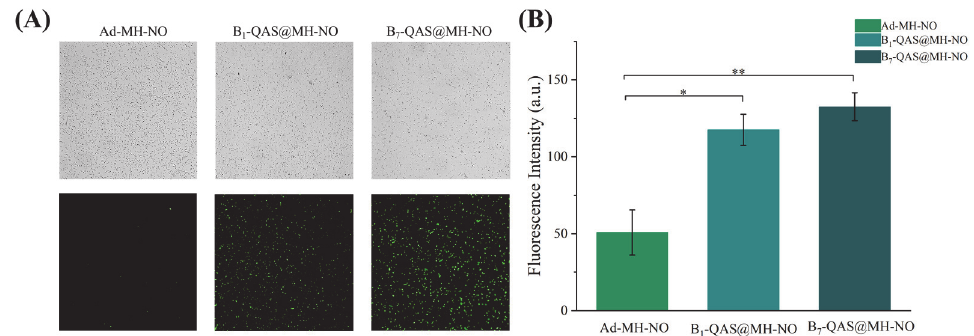
Figure 7. ( A ) NO fluorescence imaging in bright and dark fields, respectively, represent the bacteria after action with Ad-MH-NO, B 1 -QAS@MH-NO, B 7 -QAS@MH-NO. ( B ) The quantitative analysis of fluorescence intensity. * p < 0.05, ** p < 0.01.